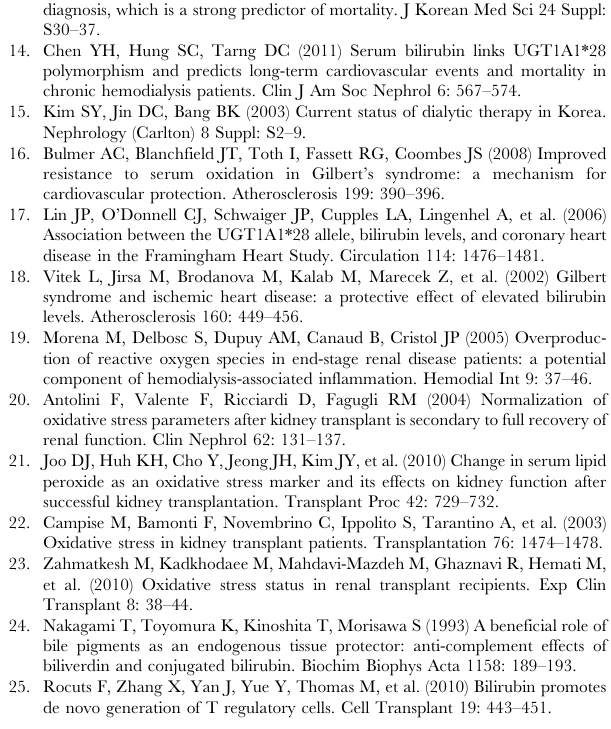
Figure S1 Genotyping of the UGT1A1*28 TA-repeat polymorphism in the TATA box at position -53. (TIF)